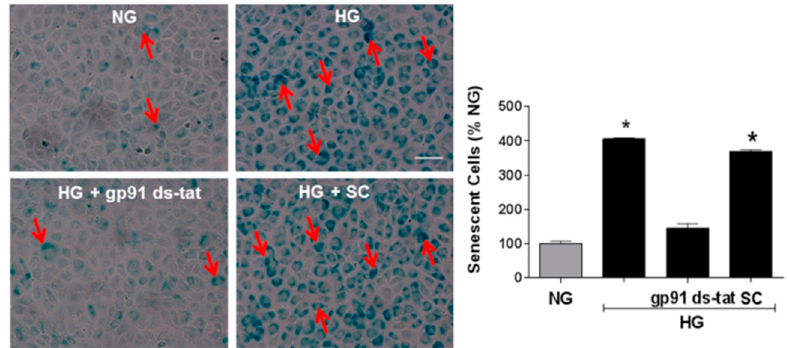
Figure 4. NOX2 blockade limits high glucose-induced increases in SA- β -gal activity. Representative images and statistical analysis showing effects of high glucose on SA- β -gal activity in retinal endothelial cells. Incubation of the cultures in high glucose (HG) media markedly increased the number of SA- β -gal-positive cells (arrows) as compared with the normal glucose (NG) controls. This was prevented by treatment with the NOX2-blocking peptide gp91ds-tat. Treatment with the scrambled control (SC) peptide did not alter the high glucose effect. * p < 0.0001 vs. NG, n = 6. Scale bar = 20 µm.